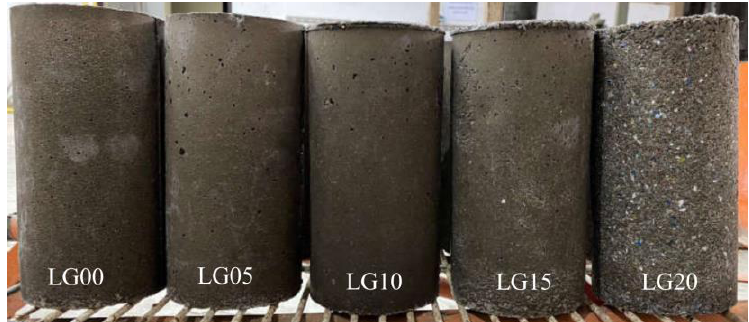
Figure 3. Geopolymer mortar specimens.